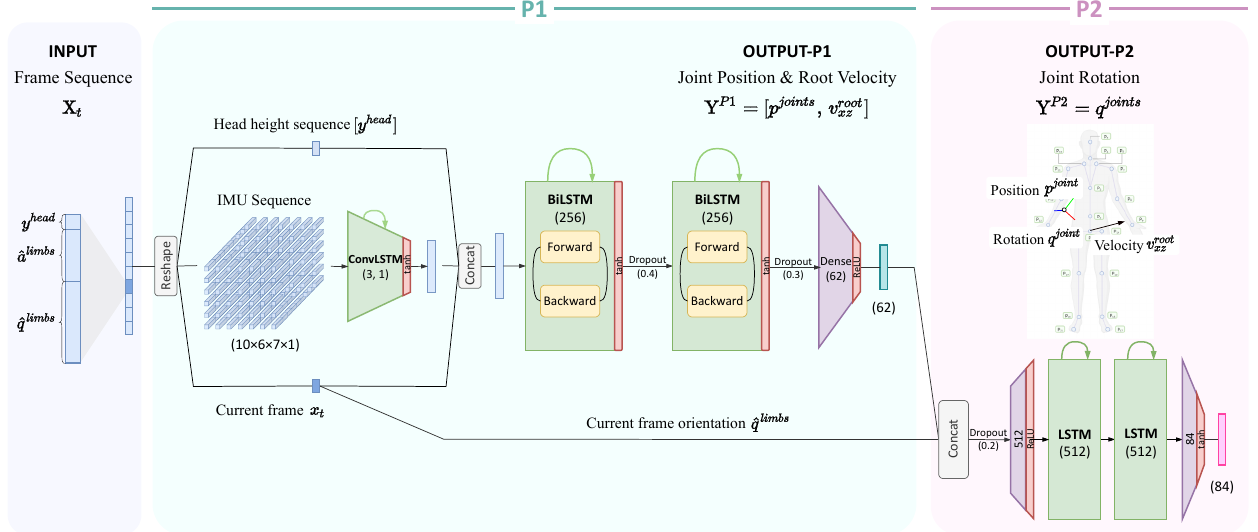
Figure 2. The Fusion Poser network architecture. The model inputs are the sequence of IMU sensor data and the height of the head. The length of the sequence is 10 time intervals, each of which has 43 features. The network consists of two stages: Phase 1 (P1) predicts the joint position using the IMU data and the head height sequences with the biLSTM layers, followed by the 4D convLSTM layers; Phase 2 predicts the joint orientation at the current time t using the output of P1 and the head height sequences with the LSTM